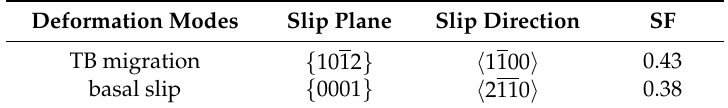
Table 1. Schmid factor (SF) of plastic deformation modes with loading axis [2 1 ̅ 1 ̅ 3].